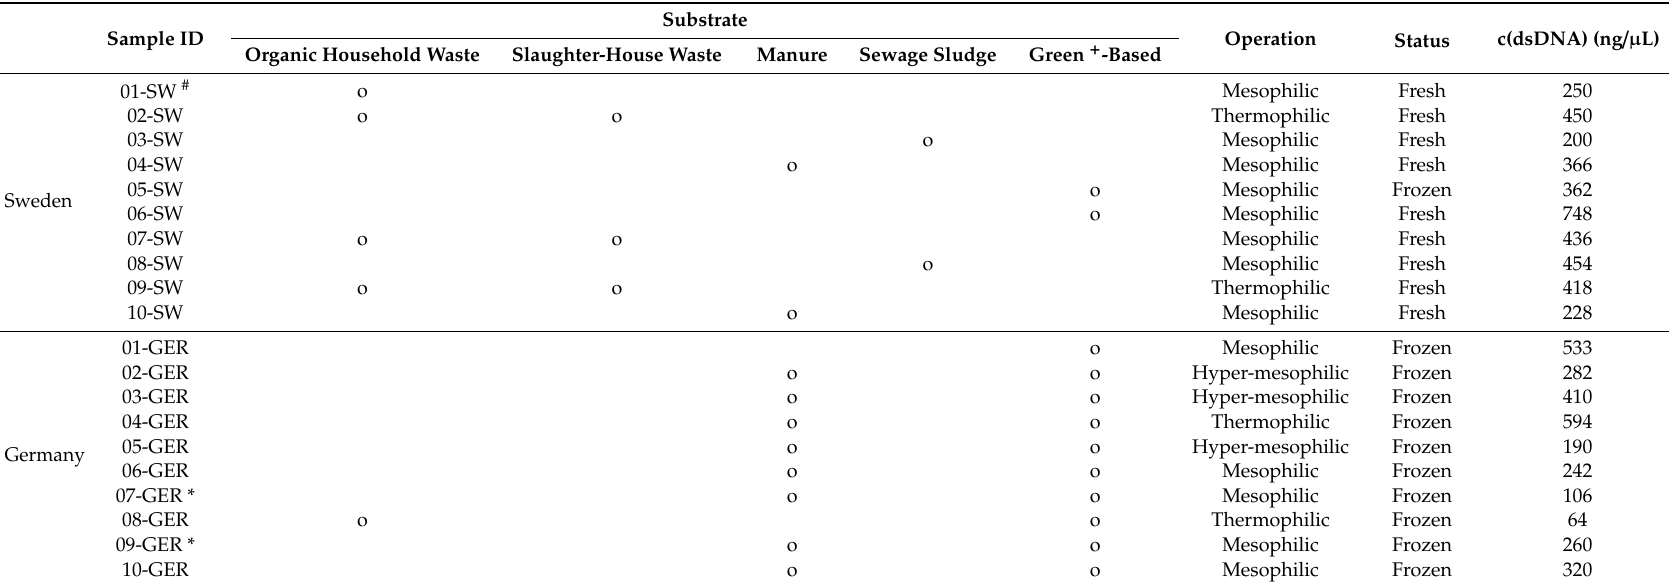
Table 1. Main substrate and temperature conditions in the 20 anaerobic digestion processes analysed in this work. The concentration of double-stranded DNA (dsDNA) after the DNA isolation and prior library preparation is also given as an